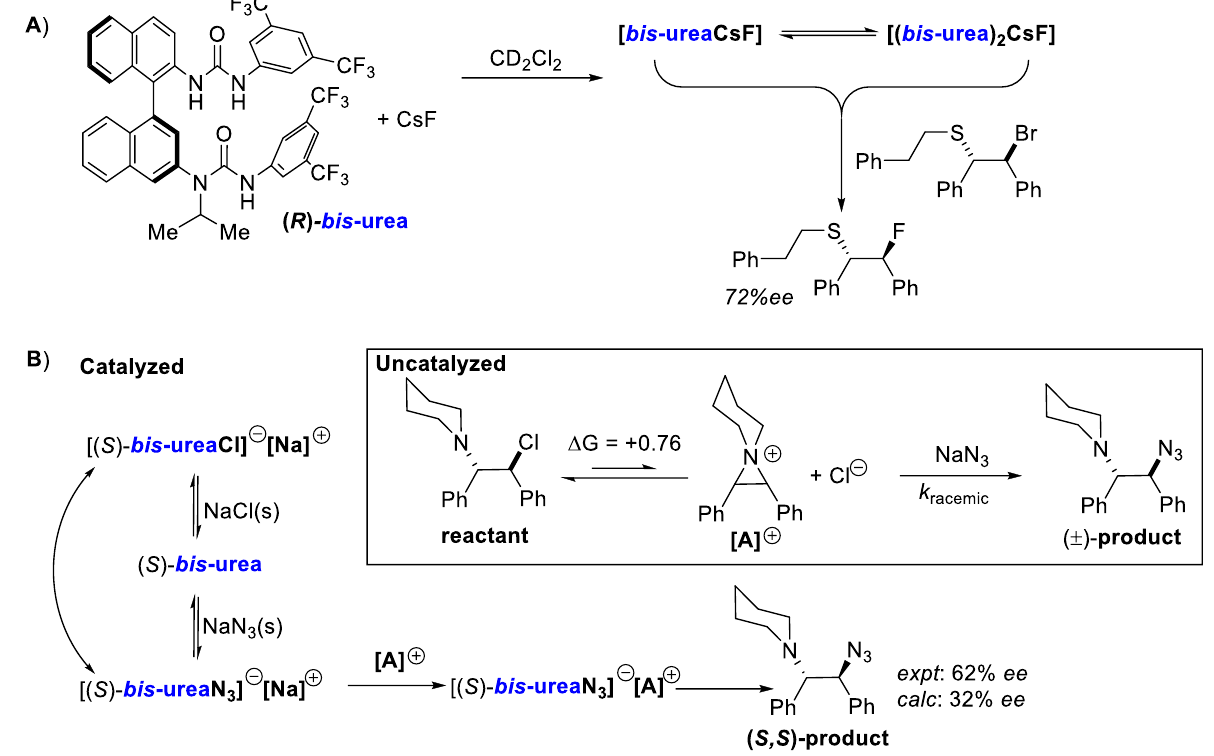
Figure 10. ( A ) Complexation of CsF and bis-urea catalyst as observed via NMR and proposed by Gouverneur, Claridge, and co-workers [117]. ( B ) Reaction pathways of bis -urea-catalyzed azidation were reported by Wong et al. [118].